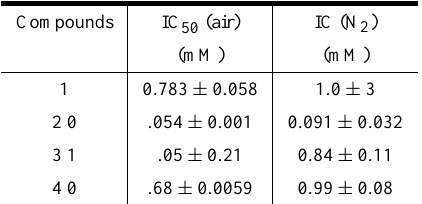
Cytotoxicity against A549 human breast tu- mor